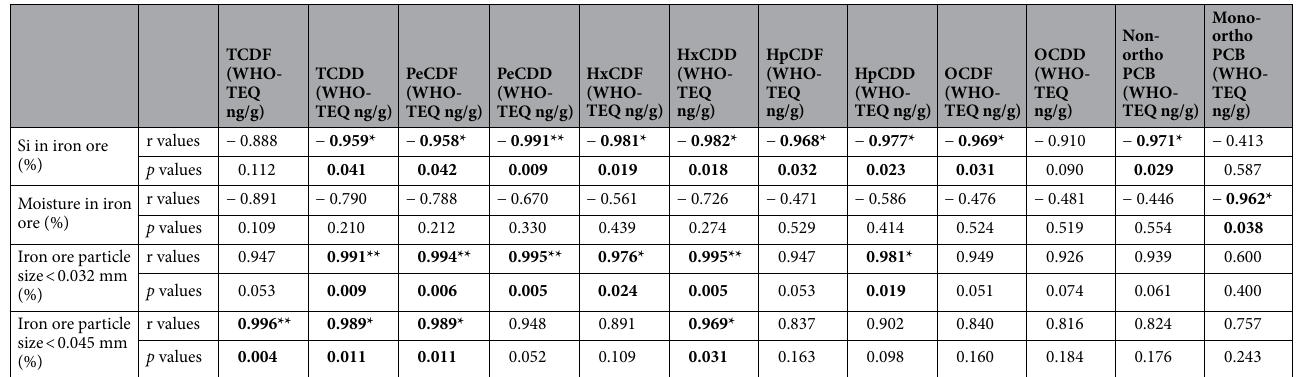
Table 3. Statistical correlations between iron ore properties and dust-related dioxin emissions. **Correlation is significant at the 0.01 level (2-tailed). *Correlation is significant at the 0.05 level (2 tailed). Significant values are in